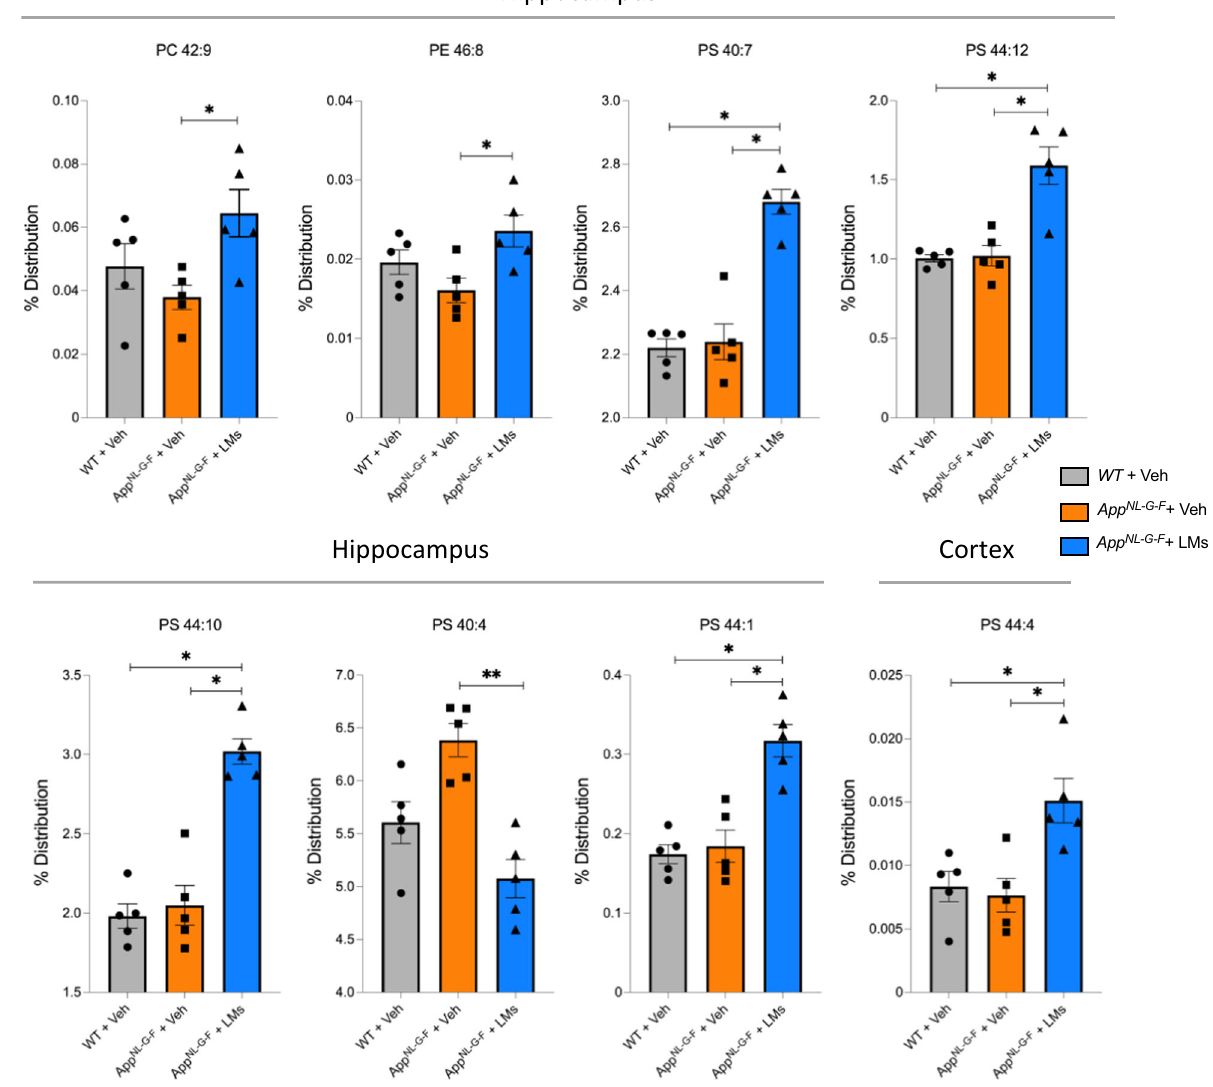
Fig. 6 DHA-containing phospholipids are elevated by treatment with LMs. Scatter plots for phospholipids analysed by LC-MS/MS in homogenates of hippocampus and cerebral cortex from wild-type (WT) and App NL-G-F mice given vehicle (Veh) and App NL-G-F mice treated with lipid mediators (LMs). A marked increase in DHA-containing phospholipids in the hippocampus can be seen for phosphatidylserine (PS) 40:7 and 44:12 upon treatment with LMs in App NL-G-F mice compared to WT controls (WT-Veh). In addition, PS 44:10 and PS44:1 are increased in the hippocampus, and PS44:4 is increased in cortex upon the LM treatment. Comparisons between treatment groups were performed with Kruskal-Wallis with Dunn ’ s multiple comparisons post hoc test, * P < 0.05, ** P < 0.01, *** P < 0.001, **** P < 0.0001. Data are presented as mean ± S.E.M. PC phosphatidylcholine, PE